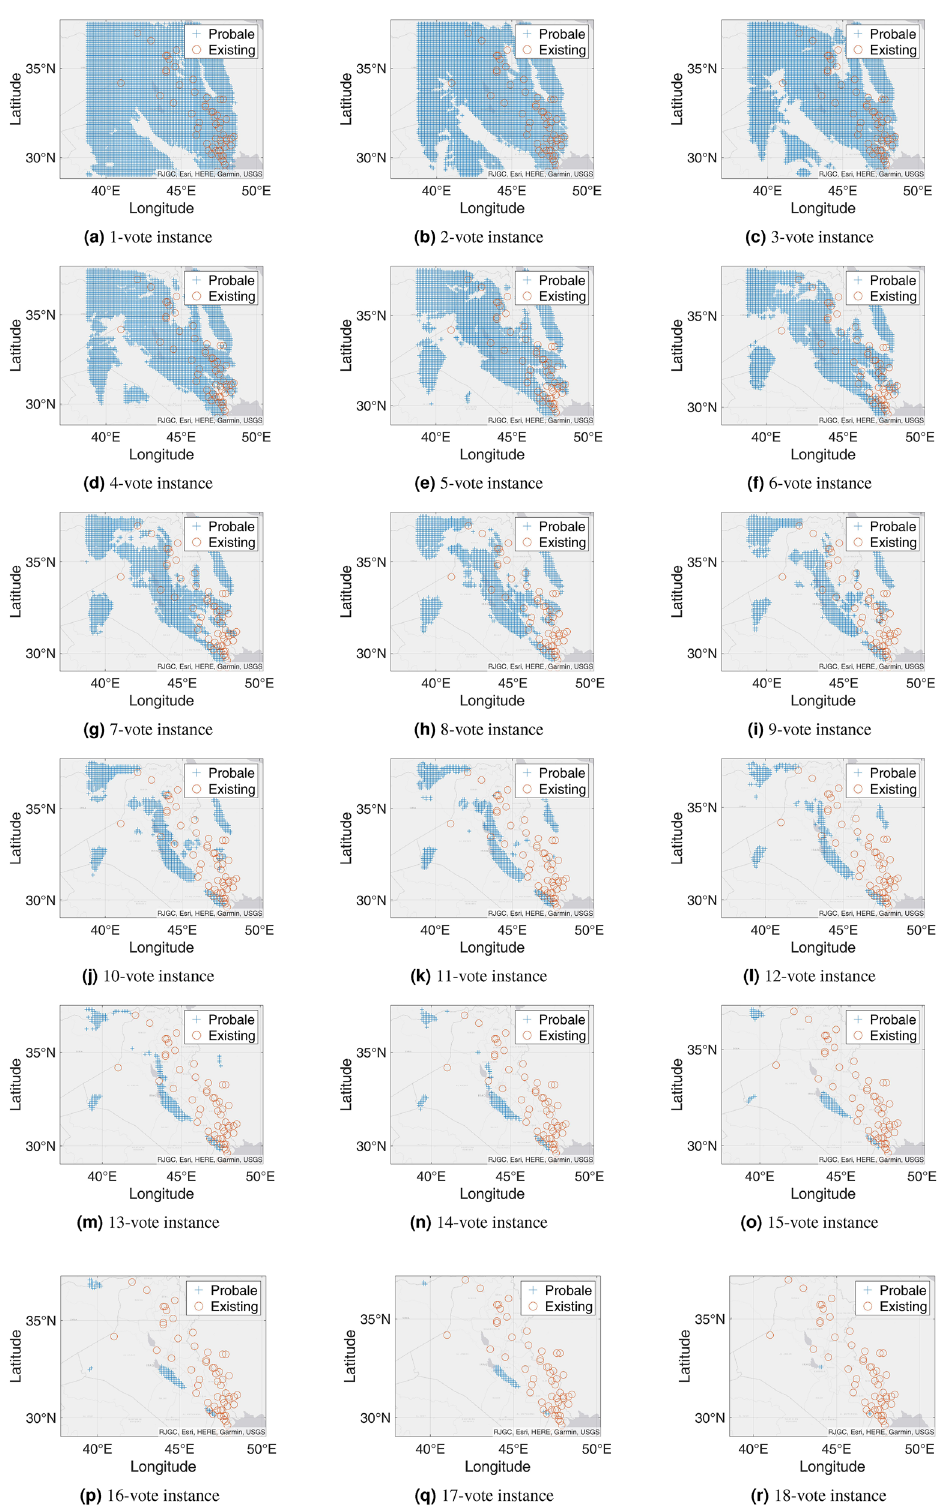
Figure 13. Probable petroleum deposits based on the existence of 1 to 18 votes over our 22 best-performing models from the matrix-based analysis over the new test dataset from Harvard (the figures are created using MATLAB 2021a 51